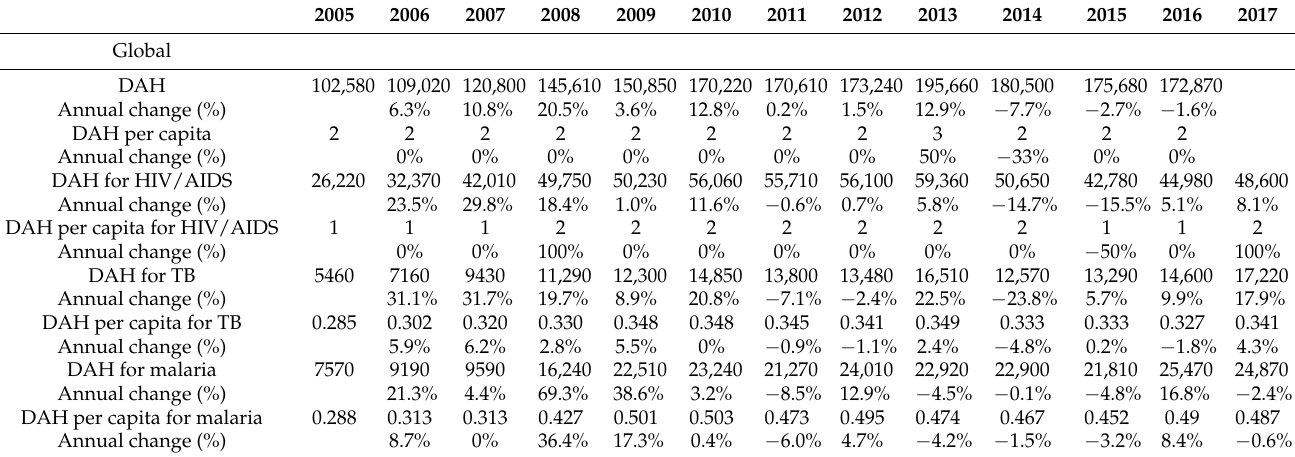
in 2006 – 2007, while the annual change of DAH for malaria peaked in 2008 – 2009 (Table 1 and Figure 1). increase (coefficient: 0.21, 95% CI 0.12–0.31, p < 0.001) in 2017. For malaria, the DAH per capita increased per mortality increase (coefficient: 0.04, 95% CI − 0.05–0.12, p < 0.001) in 2017. Overall, the coefficient increased over time during the study period. The analysis results for the association for every single year from 2005 throughout 2017 are presented in the Supplementary Materials. The results of the multicollinearity indicated a very low correlation between the independent variables (most of the VIFs were less than 2, a few VIFs were between 2–2.5). Table 1. Development assistance for health (DAH) to HIV/AIDS, tuberculosis, and malaria 2005–2017.